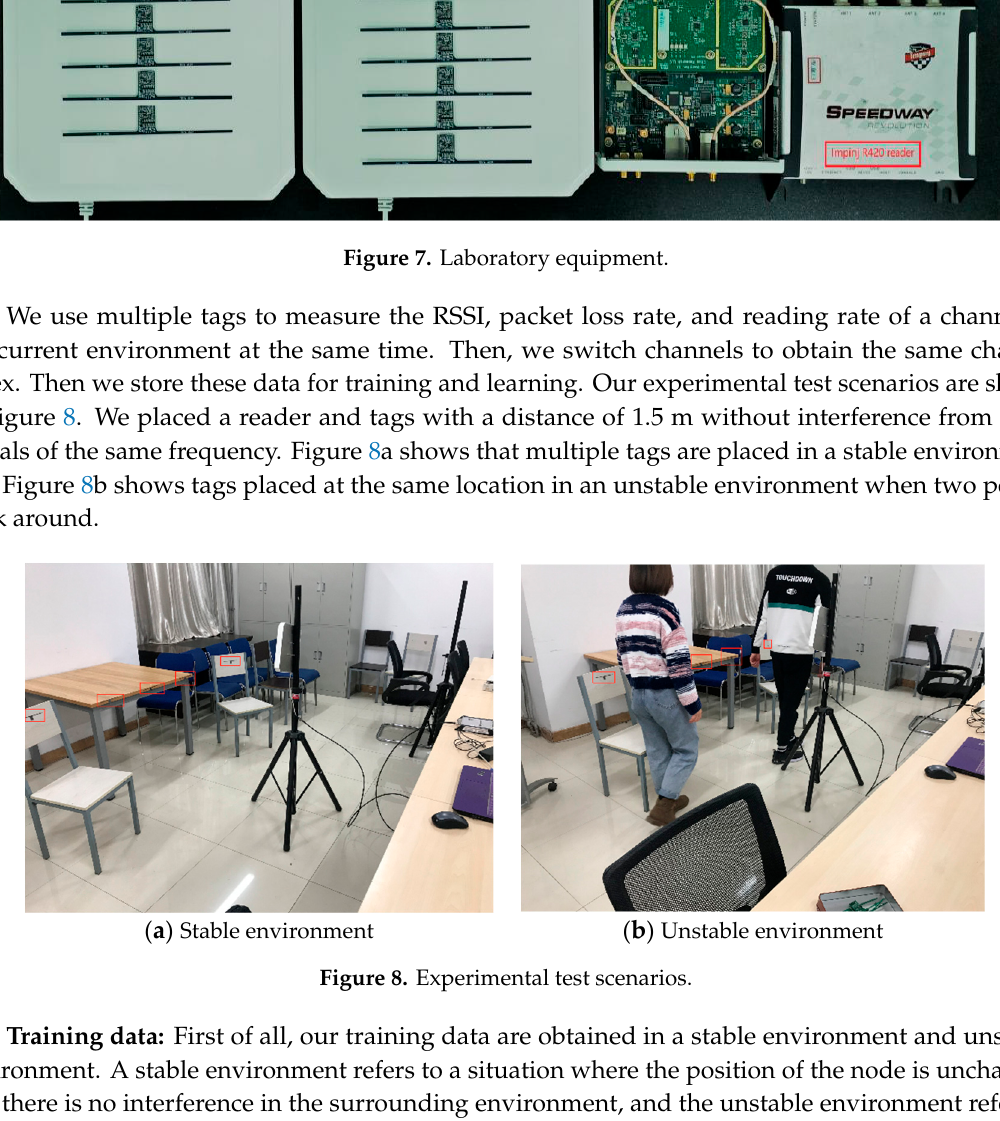
Figure 8. Experimental test scenarios.